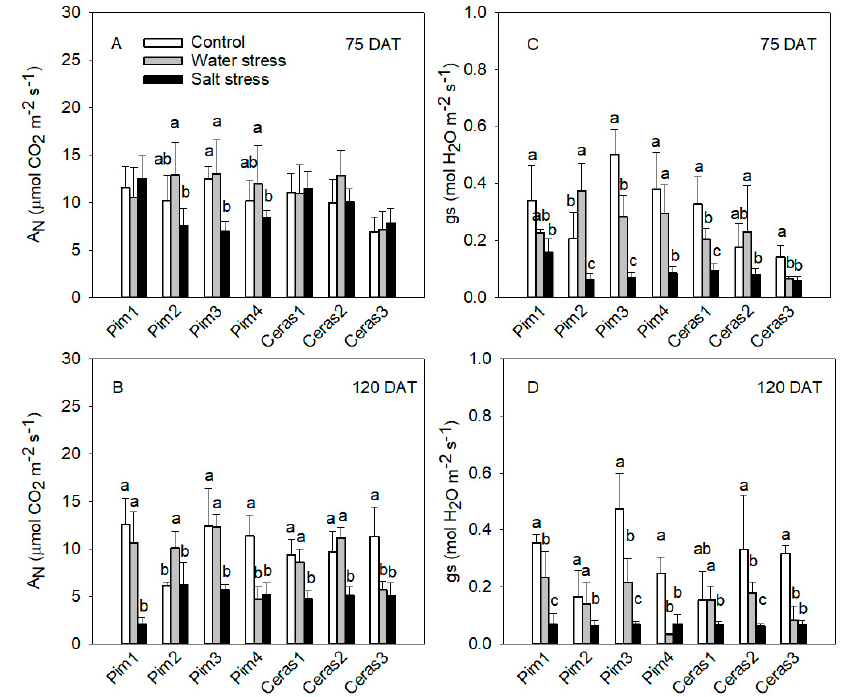
Figure 2 . Net CO 2 assimilation rate ( μ mol CO 2 m − 2 s − 1 ) ( A , B ), and leaf stomatal conductance (mol H 2 O m − 2 s − 1 ) ( C , D ) in accessions Pim1, Pim2, Pim3, Pim4, Ceras1, Ceras2 and Ceras3 under control, water